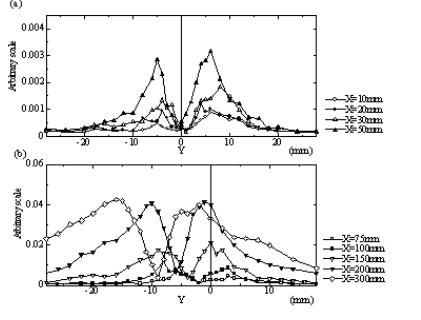
Fig. 12 Amplitude distribution of the fundamental mode